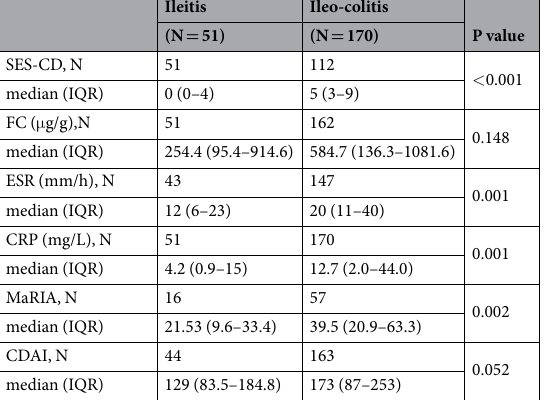
Table 2. Clinical and laboratory characteristics according to disease location in small bowel Crohn’s disease patients. IQR, interquartile range; SES-CD, simple endoscopic score for Crohn’s disease; FC, faecal calprotectin;